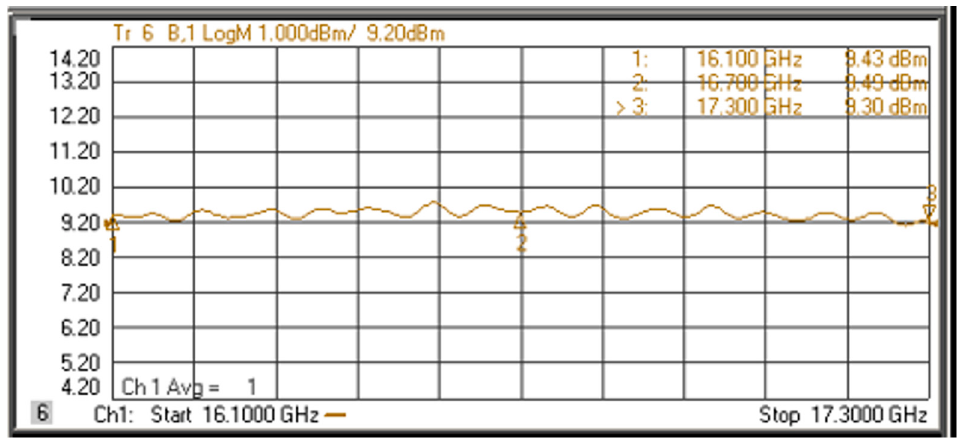
Figure 11. Measured results of transmit. The measured output power is between 9.12 dBm and 9.76 dBm, with a difference of less than 0.7